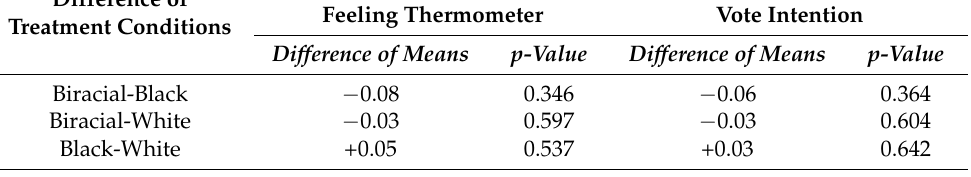
Table A6. Results from difference-of-means t -tests for all possible treatment group comparisons in Figure A3. Difference of Treatment